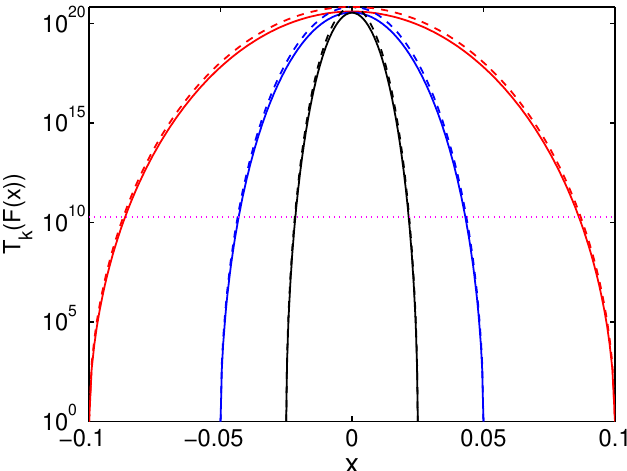
Figure 1: The exp-semicircle filters for a = 0.1 (red lines), 0.05 (blue lines), = 1 and and 0.025 (black lines), with ka = 24. We have set E max = − 1. The solid lines are for the Chebyshev polynomials T ( F ( x )) , where E k min (cid:2) (cid:3) / ( F ( x ) = 2 x 2 − ( 1 + a 2 ) 1 − a 2 ) , while the dashed lines are for the approxima- (cid:112) ( F ( x )) . The horizontal pink dotted line denotes the a 2 − x 2 ) (cid:39) T tions y = exp ( 2 k k ( F ( x )) | ≤ 1 when x / ∈ [ − a , a ] , half maximum of the logarithm of filters. Note that | T k thus the filter regions are restricted in [ − a , a ]